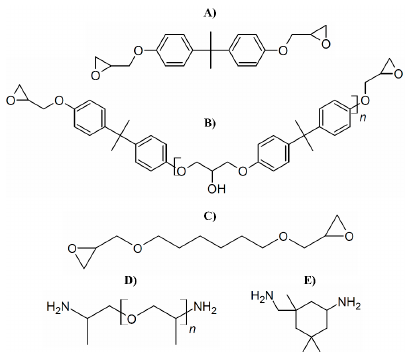
Figure 1. Molecular structures of epoxy and hardener components: ( A ) DGEBA monomer; ( B ) DGEBA oligomer (n = 1–2); ( C ) HDDGE; ( D ) POPA; ( E )